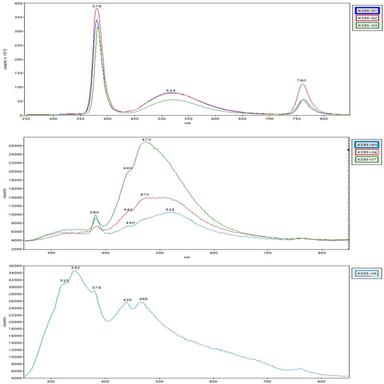
Representative CL spectra for each of the distinct layers of a cross section from the painting 'Hydra' – K595 (Top: zone 1 to 3; Middle: Zone 5 to 7; Bottom: Zone 8). Zone 4 represents the substrate and was not analyzed.